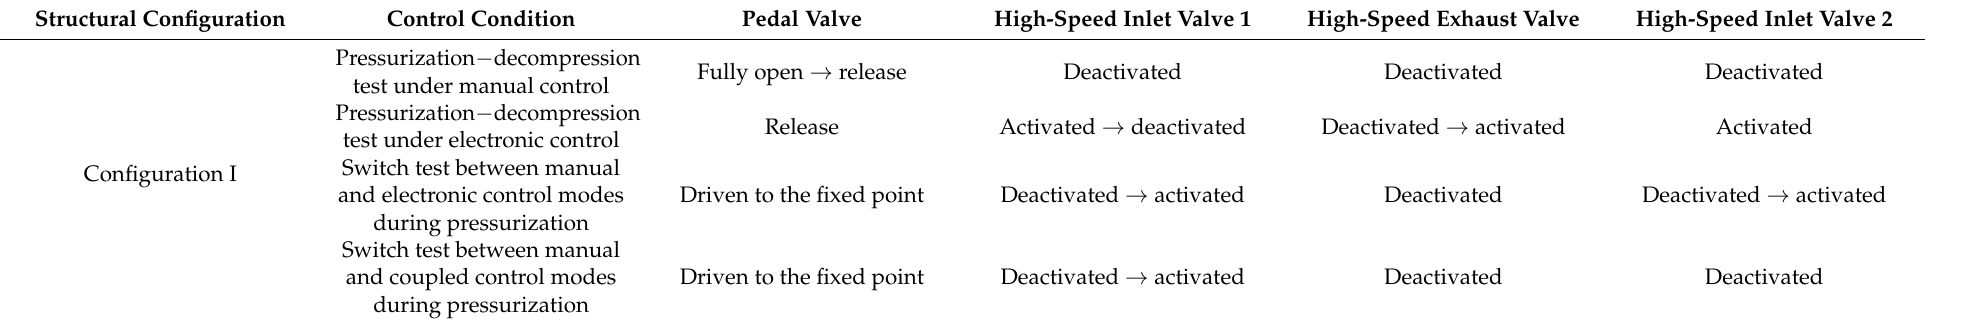
Table 2. Control conditions for the test of the pressure regulation characteristics of the APRV in structural configuration